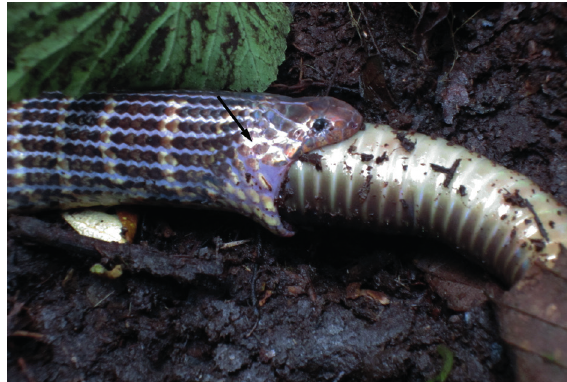
Figure 7 - General view of an uncollected specimen of Atractus sp. eating an earthworm in the field at Parque Nacional Sangay (02◦ 04’27.5”S, 78◦12’46.6”W; 1785 m asl), province of morona Santiago, ecuador. This specimen had about 750 mm of total length. Black arrow indicates the quadrate-mandibular joint displaced backward during swallowing process. Photo by Hérnan Orellana.